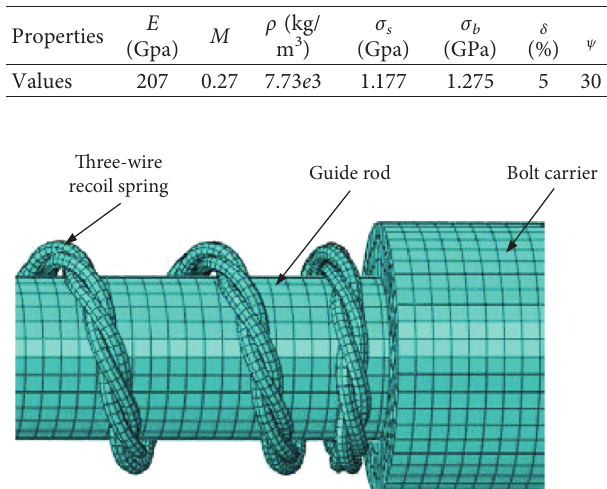
Figure 9: Meshing of recoil spring, guide rod, and bolt carrier.